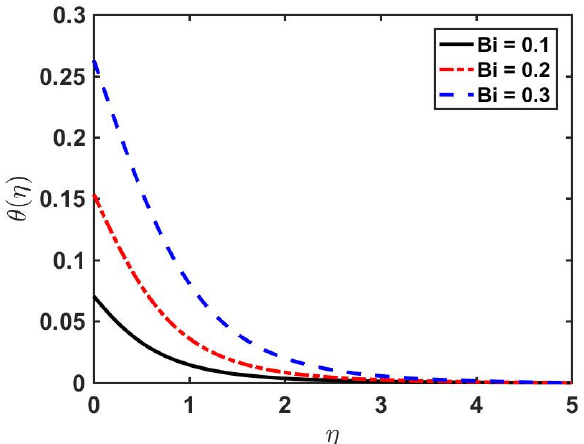
Figure 4. Effect of 𝑩𝒊 on 𝜽(𝜼) .